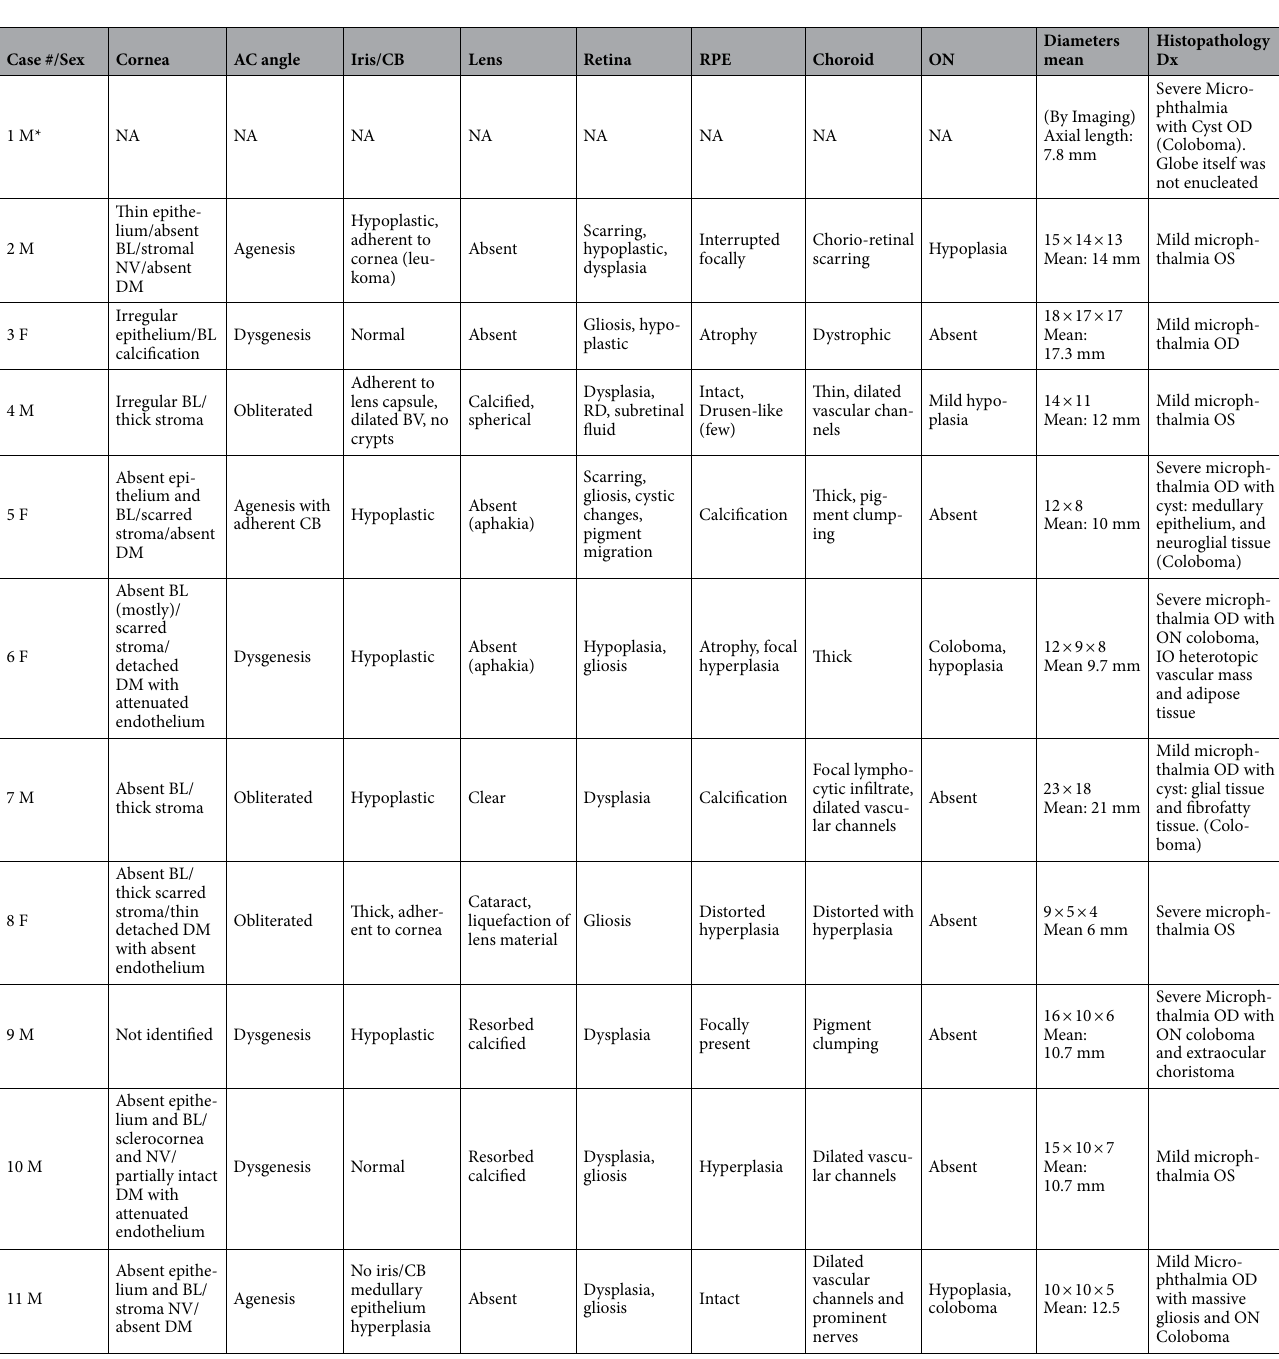
Table 2. Histopathological characteristics in 10 globes from 11 patients who are diagnosed with microphthalmos. M male, F female, NA not applicable, BL Bowman’s layer, NV neovascularization, DM Descemet’s membrane, AC anterior chamber, CB ciliary body, BV blood vessels, RD retinal detachment, RPE retina pigmented epithelium, ON optic nerve, OD right eye, OS left eye, IO intraocular. *Case 1: The globe was not enucleated because it was mildly microphthalmic with clinically normal anterior segment, but the globe had posterior coloboma with a cyst, which was excised. Therefore, histopathological ocular details were available for 10